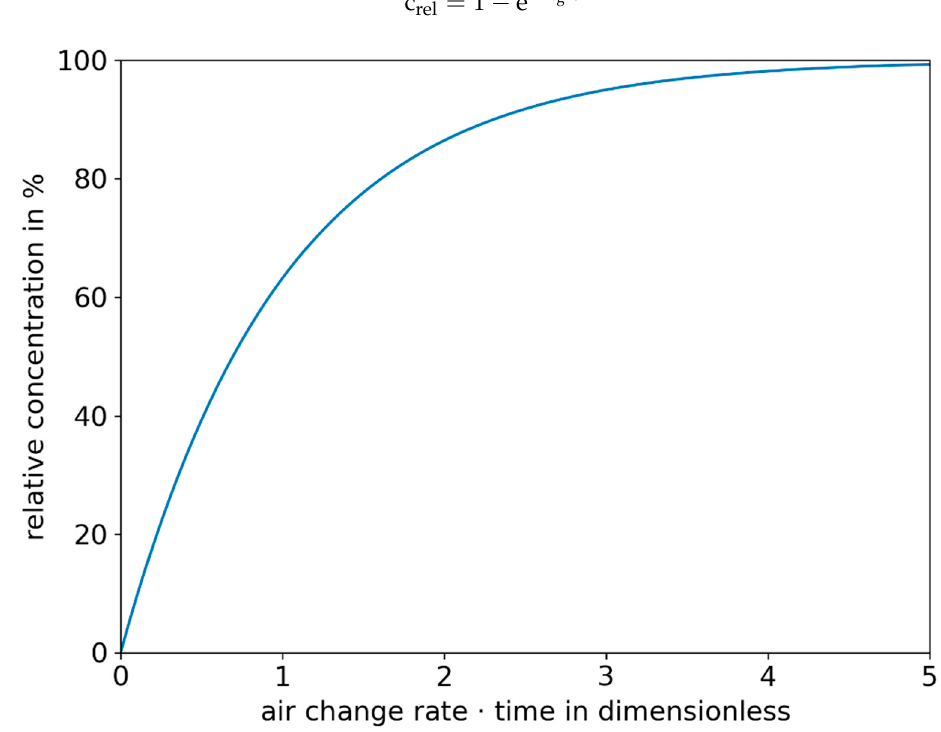
Figure 1. Relative concentration curve as a function of air change rate and time, based on the steady-state concentration.